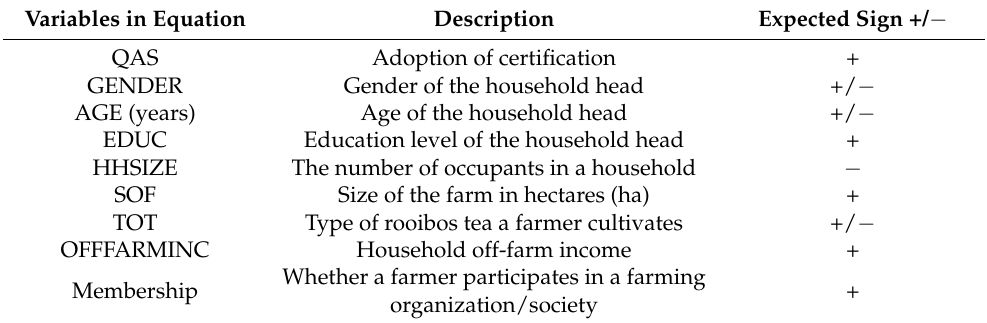
Table 1. Variable descriptions.